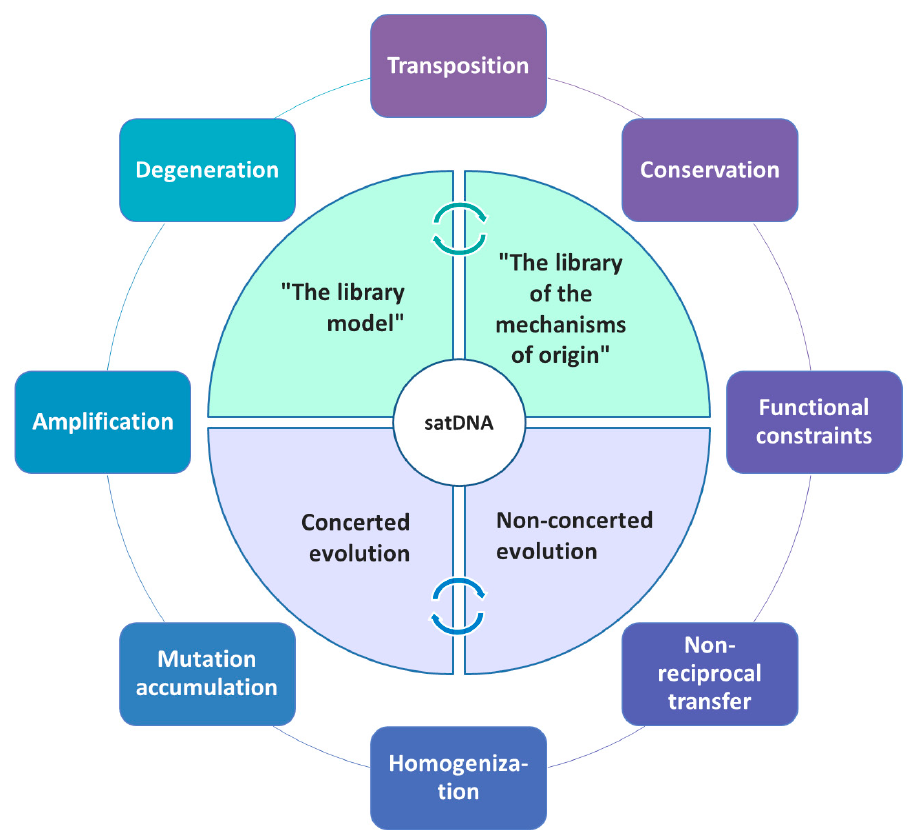
Figure 1. Schematic presentation of different mechanisms and major principles governing/influencing satDNA evolution. satDNA